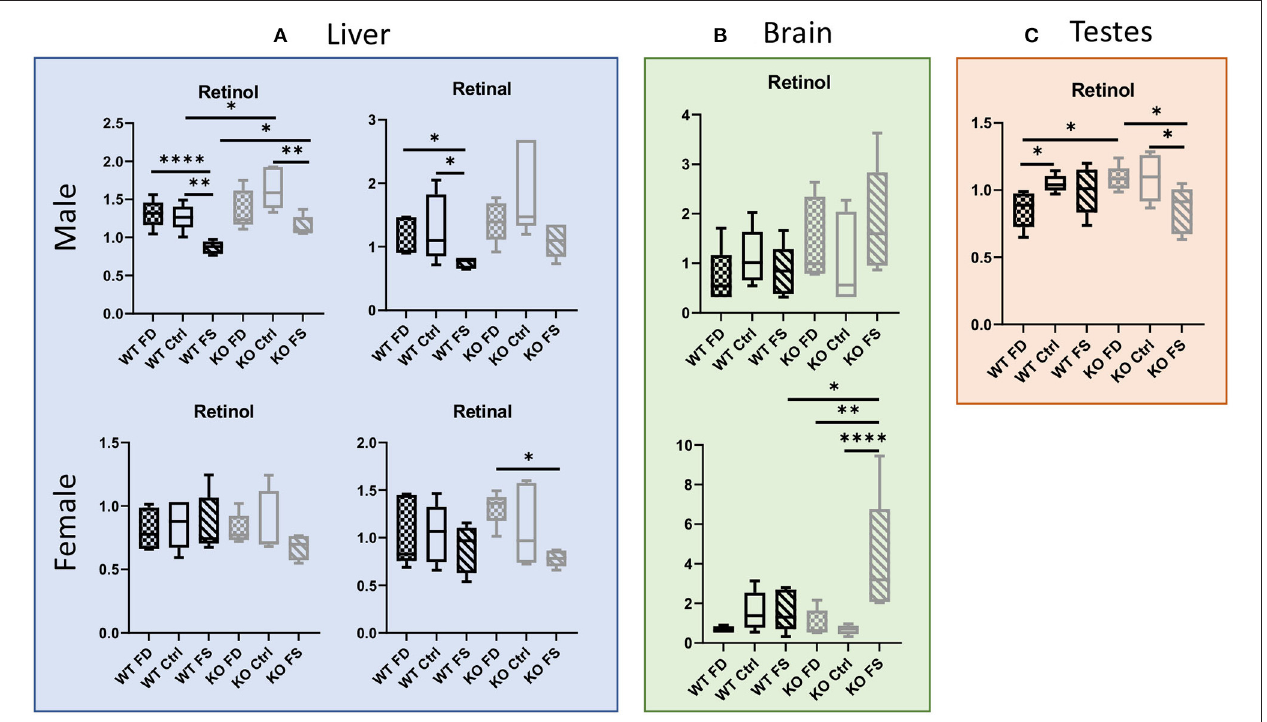
FIGURE 1 | (A) Hepatic vitamin A metabolites are altered by dietary folic acid (FA), with changes in females being CerS6-dependent. (B) Higher variability of retinol concentrations was found in brains. (C) Response of retinol concentrations in testes was also CerS6-dependent. Data show minimum and maximum, with the bar at median value, n = 5. Checked bars, folic acid-deficient (FD) diet; solid bars, control (Ctrl) diet; striped bars, FA over-supplemented (FS) diet. Wild-type (WT) is shown in black, and knockout (KO) is shown in gray. * p < 0.05; ** p < 0.01; **** p < 0.0001; determined by analysis of variance (ANOVA)